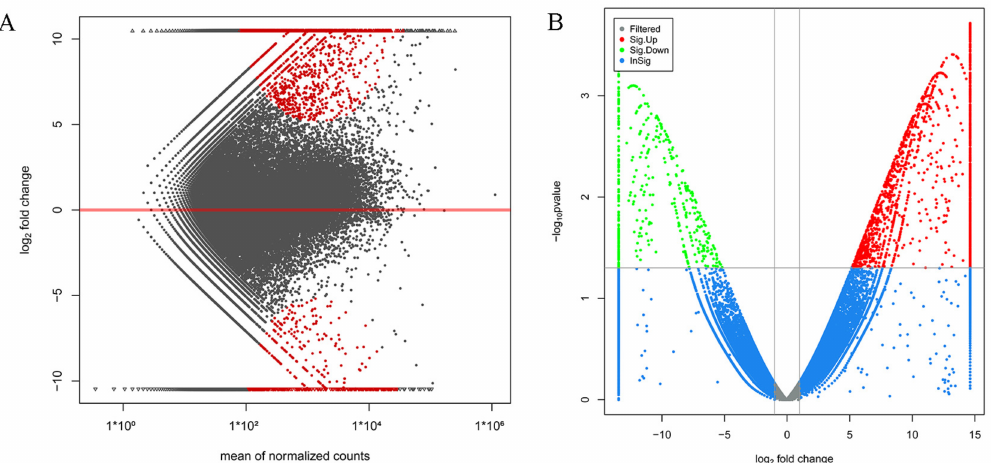
Figure 1. MA map and volcano map of DEGs. ( A ) is the MA map of the DEGs’ distribution in the testis and in the ovary of M. rosenbergii ; the horizontal x -axis is the normalized average, and the y -axis is a log 2 FoldChange. Each dot represents one gene. The red dots represent the DEGs. ( B ) is a volcano plot of the DEGs’ distribution in the testis and the ovary of M. rosenbergii ; the horizontal axis is a log 2 FoldChange, and the vertical axis is a log 10 p -value. Each dot represents one gene. The DEGs are marked in red and